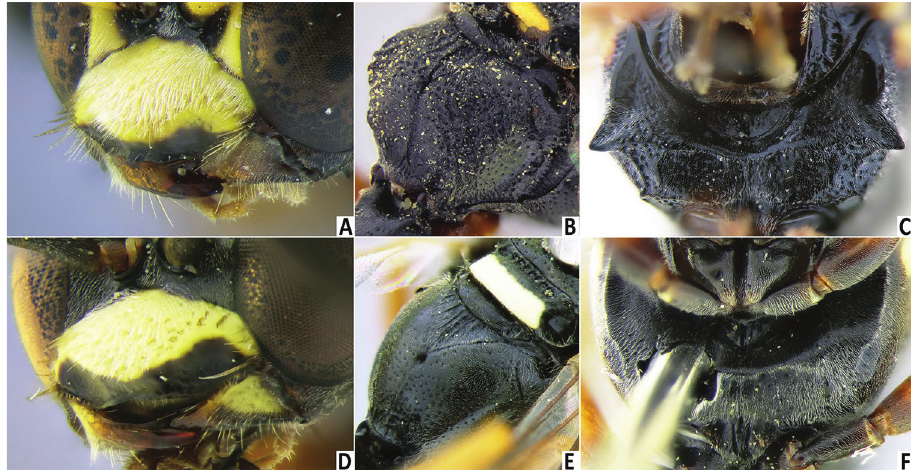
Figure 5. Hoplisoides gazagnairei (Handlirsch) from Tunisia [FSCV] ( A–C ), and H. distinguendus (Ya- sumatsu) from Buryatia, Russia [FSCV] ( D–F ), males: A , D clypeus, frontolateral view B , E scutellum, metanotum and propodeum, posterolateral view C , F metasoma, ventral